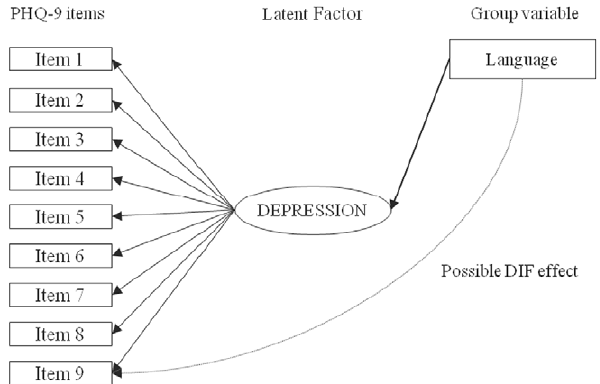
Figure 1. MIMIC model for Patient Health Questionnaire - 9 (PHQ-9). The base Multiple-Indicator Multiple-Cause (MIMIC) model consists of a confirmatory factor model with the additional direct effect of group (language) on the latent depression factor serving to control for group differences on the level of the latent depression factor. For differential item functioning (DIF) analysis, the direct effect of group on PHQ-9 items is assessed for each item separately by regressing items, one at a time, on language, controlling for any differences in the